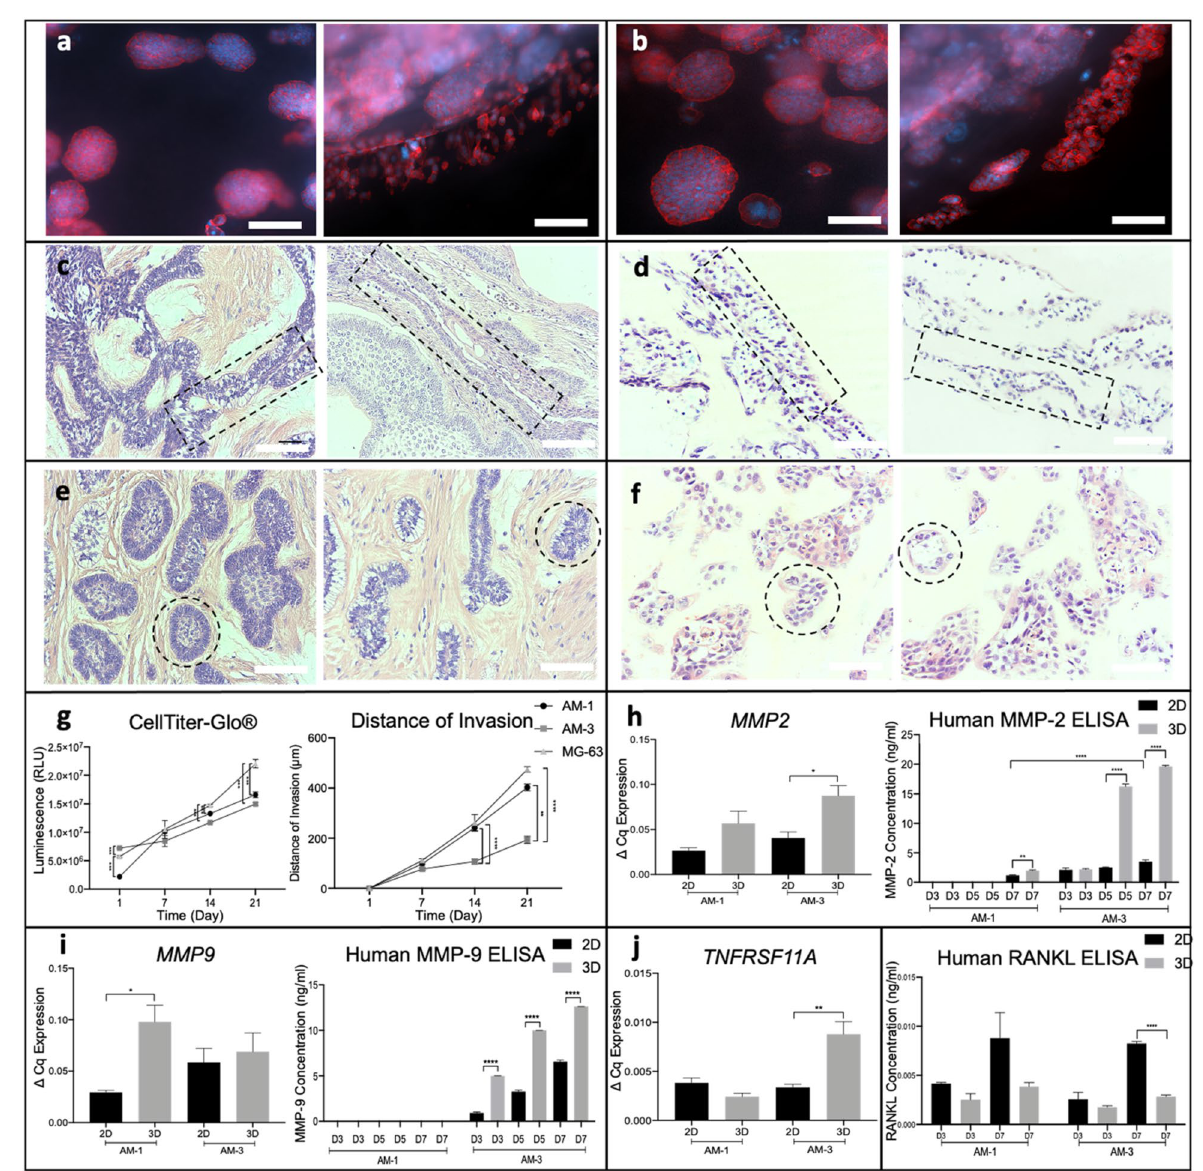
Figure 3. Characterisation of ameloblastoma cells in 3D culture. Spheroid formation of ( a) AM-1 cells and ( b) AM-3 cells in 3D tumouroids at day 7, red = Phalloidin, blue = DAPI, 20 × Magnification Scale Bar = 50 μm. ( c) Histology H&E staining of plexiform patient samples, ( d) 3D AM-1 tumouroids, e follicular patient samples, and (f) 3D AM-3 tumouroids. Similar anastomosing cords and branches were highlighted ( c, d) 10 × Magnification Scale Bar = 100 μm. The formation of the odontogenic islands was highlighted ( e,f) . ( g) CellTiter-Glo 3D Viability-Assay of AM-1, AM-3 and MG-63 cells in 3D tumouroids. Distance of invasion (μm) AM-1, AM-3 and MG-63 cells from the tumour mass to the surrounding stroma within the 3D tumouroids. ( h) Human MMP-2 ELISA. Expression of MMP2. ( i) Human MMP-9 ELISA. Expression of MMP9. ( j) Expression of TNFRSF11A (RANK). Human RANKL ELISA. One-Way ANOVA, Dunnet’s Post Hoc; p-values 0.05 = *, 0.005 = **, 0.0005 = *** and 0.00005 = Characterisation of bone nodules in the 3D bone stroma model. The bone nodules produced in the 3D bone stroma were verified by using well-established bone nodule characterisation methods. Alizarin red stain detected calcium within the bone nodules, including calcium dense areas (dark red) and less dense areas (light red) (Fig. 4b). The height of the bone nodules (z-axis) in the 3D bone stroma were measured. The average height was 92.37 ± 4 7.96 μm with a maximum height of 121.81 μm (Fig. 4b), in line with previously defined sizes of bone nodule (70–100 μm) 53,54 (details of the height measurement were provided in the Supplementary Fig. 4). TEM imaging of the bone nodules shows dense collagen fibrils around the mineralised bone nodules (Fig. 4b). The osteoblast and mineralisation marker ALPL 55 was higher in 3D compared to 2D at day 7 and 8 (p = 0.05, p = 0.005 respectively). The osteocyte marker E11 56 , was detected in the 3D bone stroma (Fig. 4b). The bone nodules were scanned from top to bottom and images were captured at different Z-stack sections of the nodules.